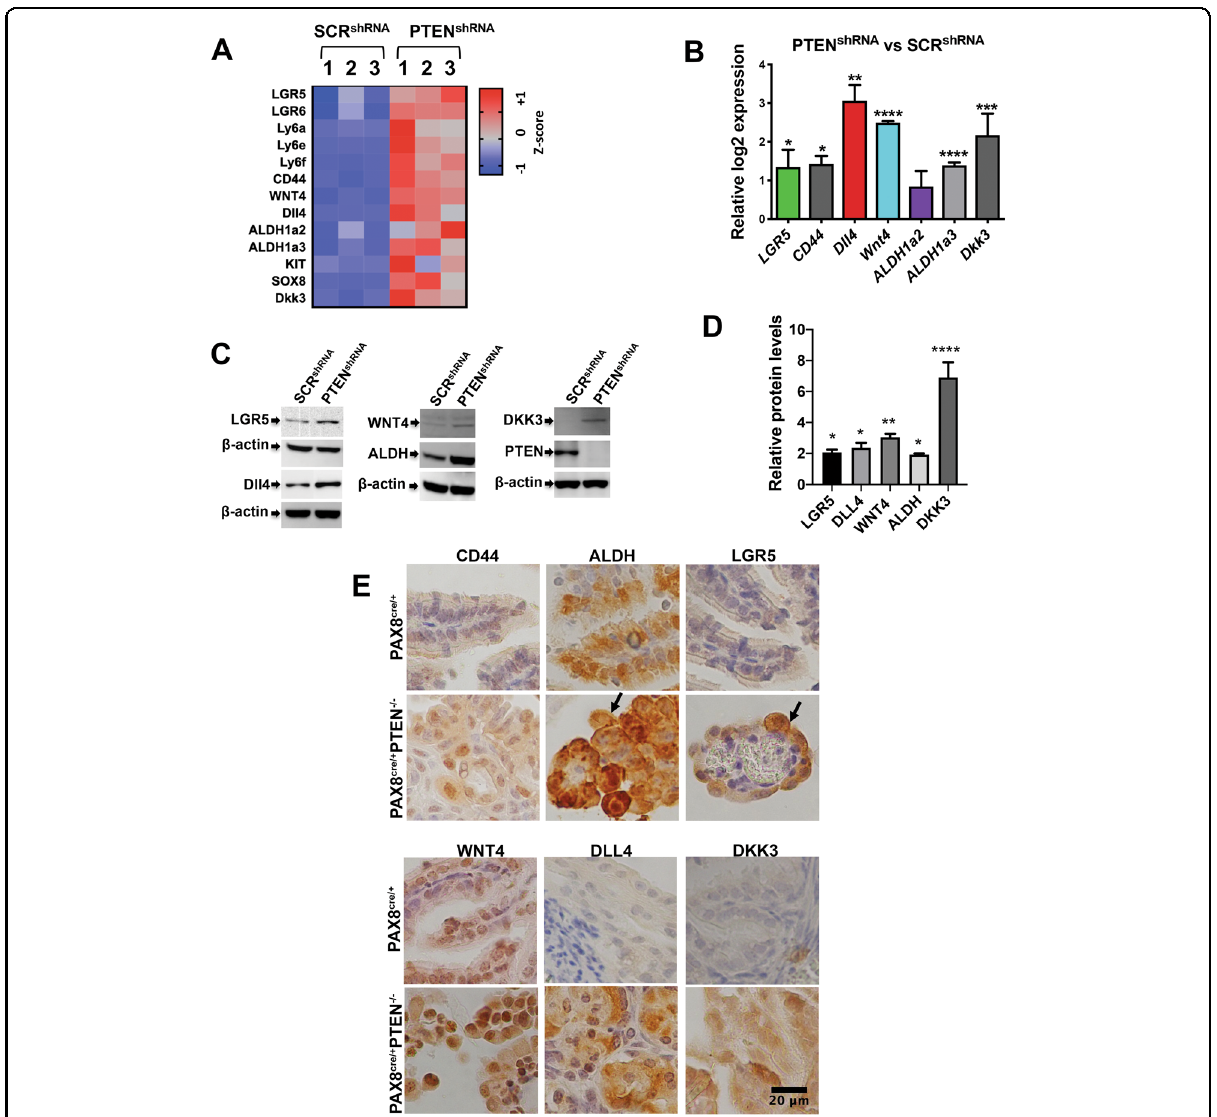
Fig. 1 Loss of PTEN increases expression of CSC markers. A Heatmap from RNAseq data obtained from MOE cells depleted of Pten (named PTEN shRNA ) compared to scrambled control (SCR shRNA ). Only signi fi cantly regulated genes involved in CSC function are plotted (* p < 0.05). B qPCR validating mRNA levels in PTEN shRNA compared to SCR shRNA . Three independent experiments, each repeated in three replicates were performed (* p < 0.05; *** p < 0.001). C Western blot of lysates from PTEN shRNA and SCR shRNA probed for DLL4, LGR5, PTEN, ALDH, and actin antibodies. D Western blot quanti fi cation of three independent experiments using ImageJ. Data were normalized to actin and fold changes over SCR shRNA calculated. Statistical analysis performed using one-way ANOVA with multiple comparisons. E Immunohistochemistry (IHC) of tissues from control PAX8 cre/ + and PTEN knockout PAX8 cre/ + PTEN fl / fl transgenic mice were stained for DKK3, DLL4, ALDH, CD44, and LGR5 antibodies to determine protein expression. Scale bar represents 20 μ m. Same observation were seen in three independent experiments using three different animals for PAX8 cre/ + and three different animals PAX8 cre/ + PTEN fl / fl